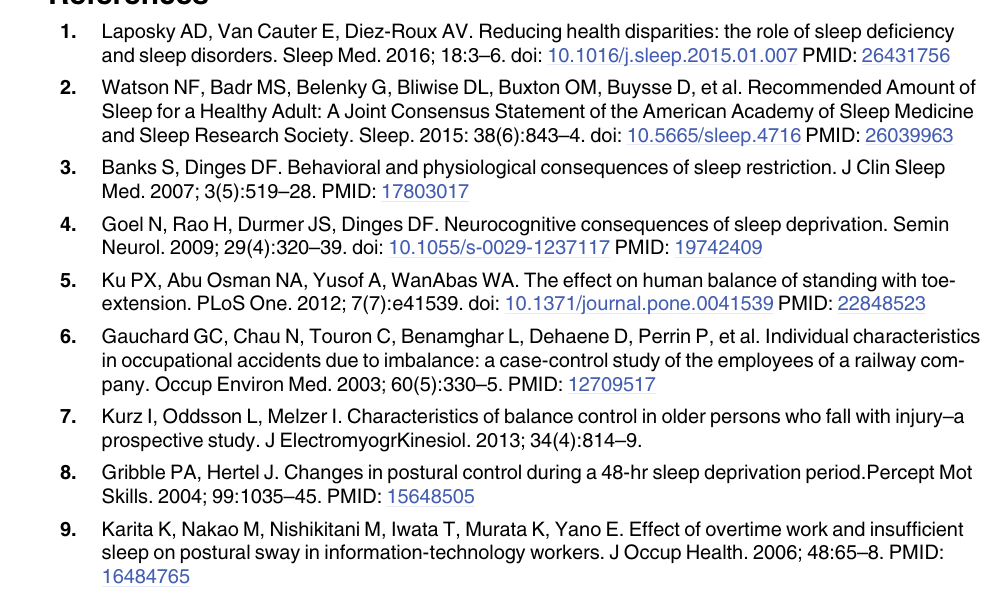
S1 Table. Statistical description of the data (Mean, variance, maximum and minimum). BMI: body mass index; TST: total sleep time; WASO: wake after sleep onset; L5: least active 5-h period;OSI: overall stability index; APSI: anteroposterior stability index; MLSI: mediolateral stability index; EOFS: eyes open on firm surface; ECFS: eyes closed on firm surface; EOCS: eyes open on compliant surface; ECCS: eyes closed on compliant